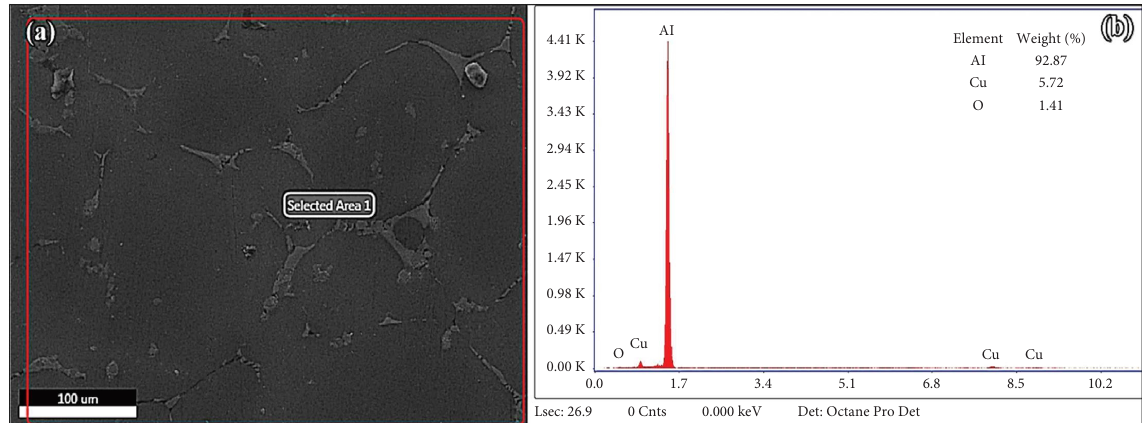
Figure 12: (a) EDS and (b) spectral analyses for interface area of bonded section at 500 ° C.